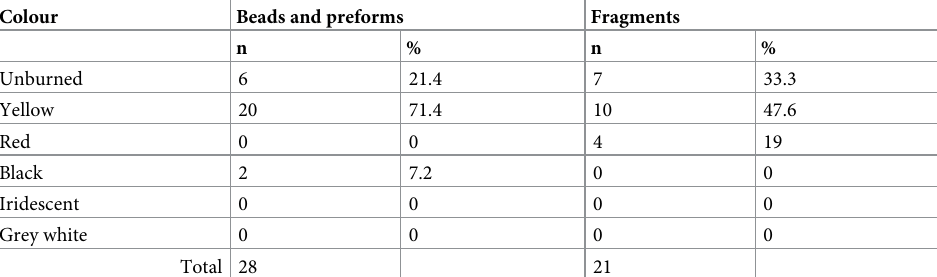
Table 1. Colouring of OES beads, preforms and fragments from the MIS 2 level at GHN. Colour was assessed fol- lowing protocol outlined by Collins and Steele [50]. Counts and percentages are